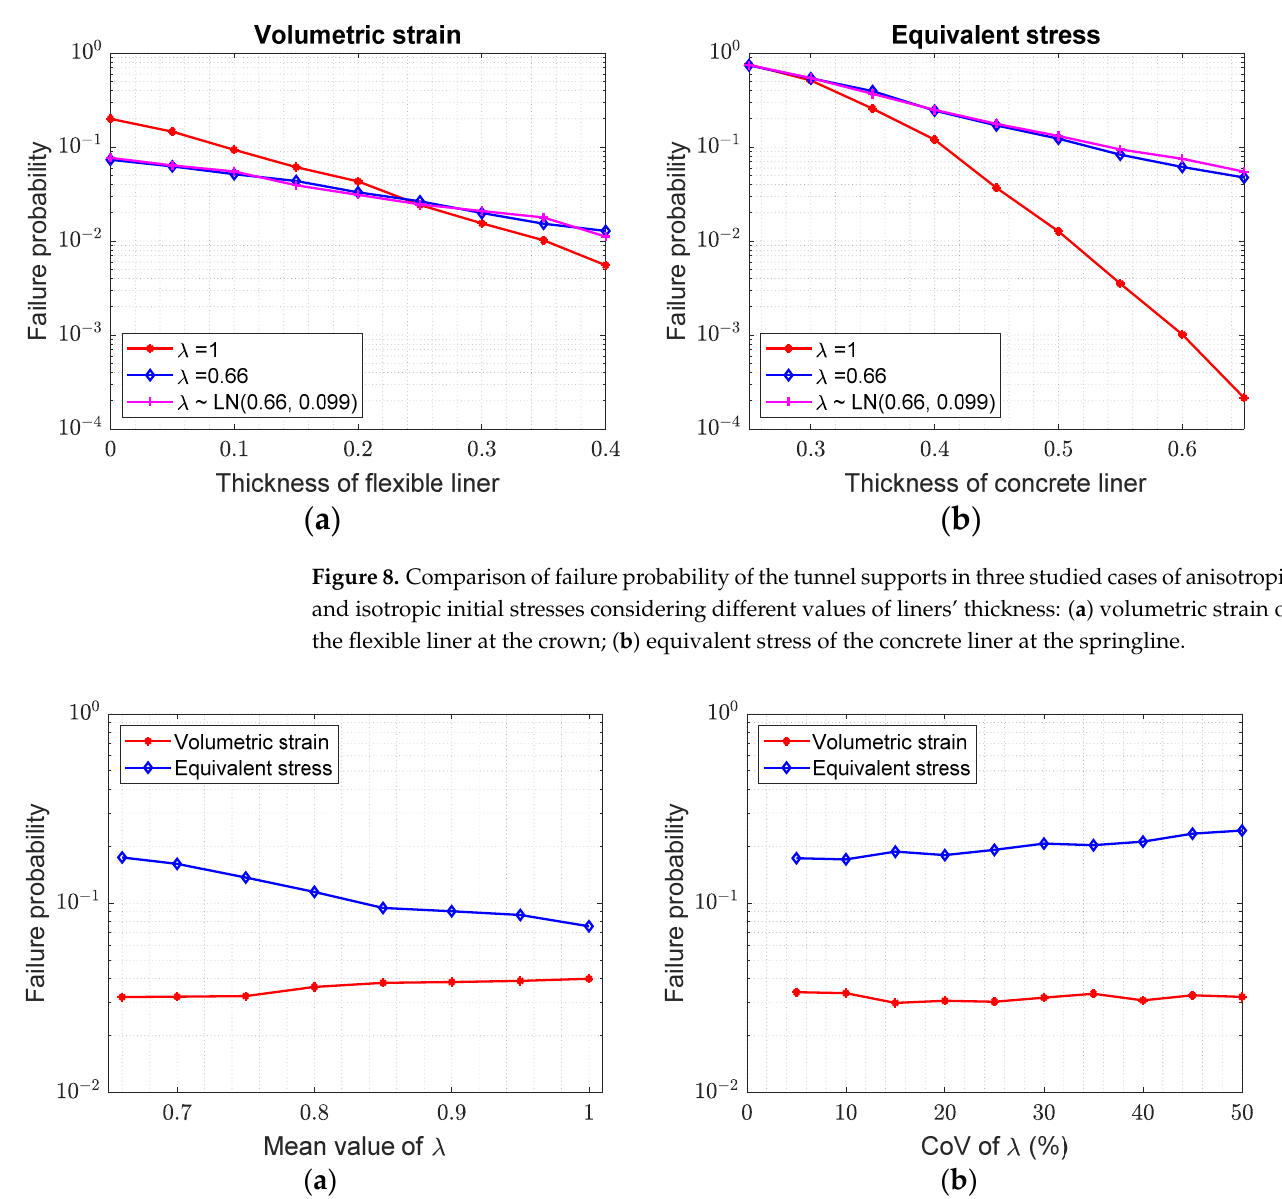
Figure 9. Failure probability of the tunnel supports as function of mean value ( a ) and CoV ( b ) of anisotropic parameter 𝜆 of initial stress state.